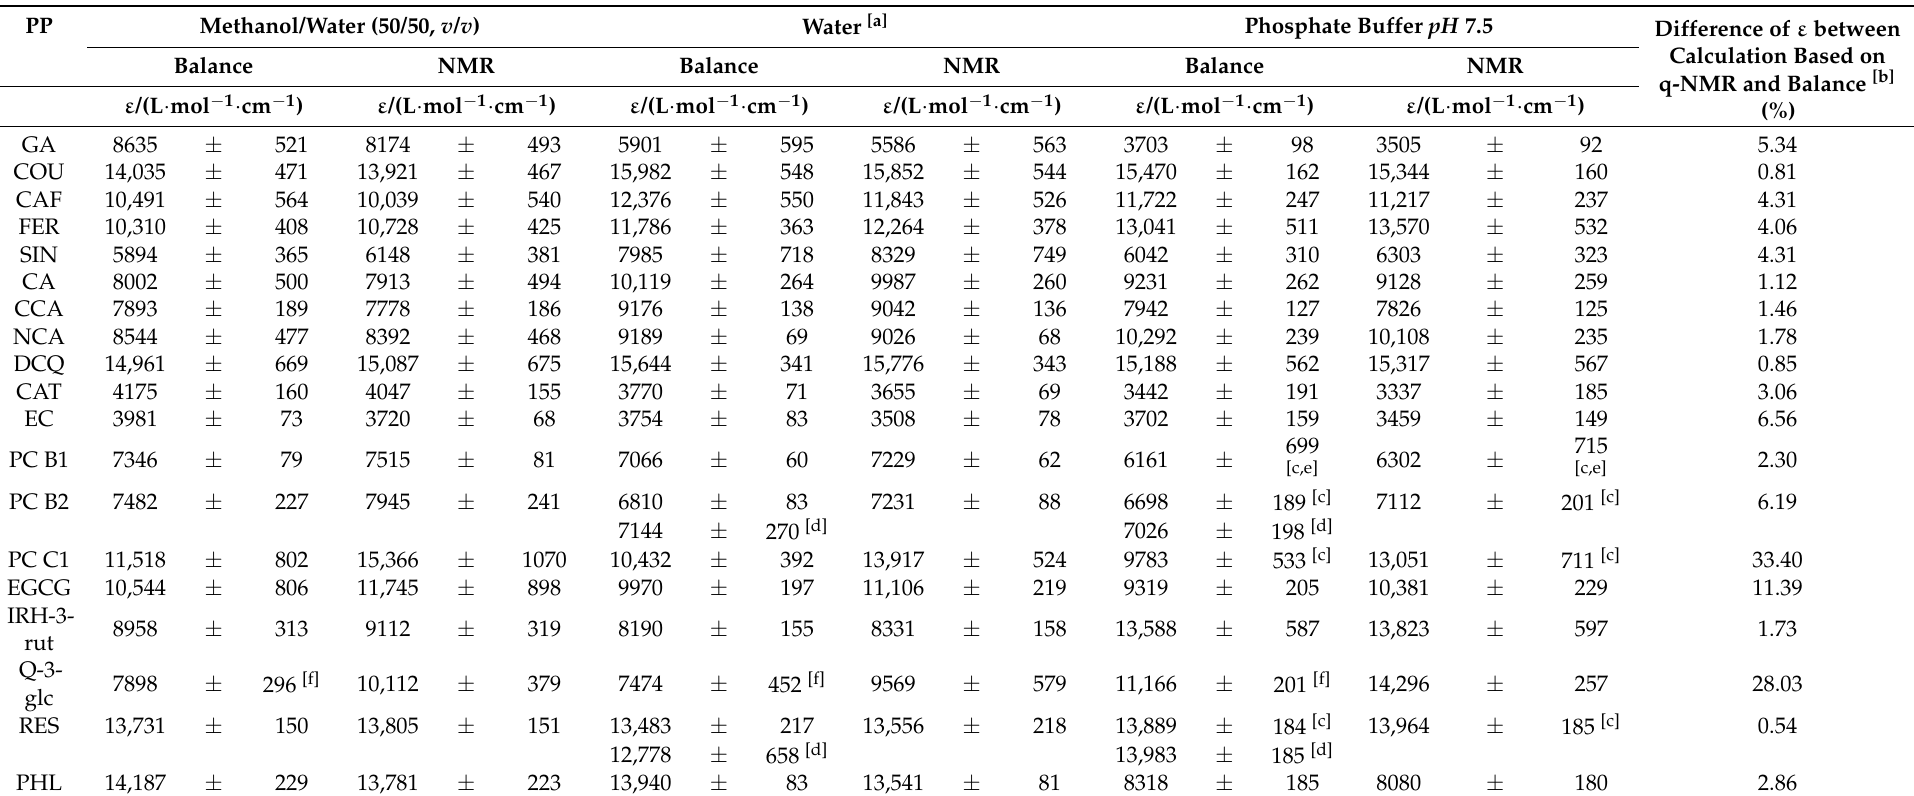
Table 2. Absorption coefficients at 280 nm for different phenolic compounds in methanol/water, water, and phosphate buffer pH 7.5 using concentrations determined by balance and